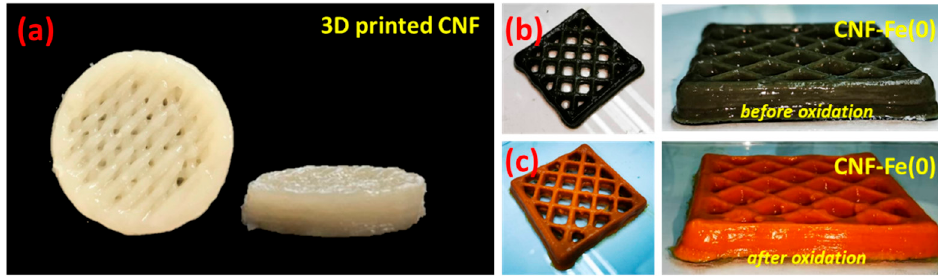
Figure 2. 3D printed structures of ( a ) CNF, ( b ) functionalized CNF with Fe(0) before oxidation, and ( c ) after oxidation reaction.